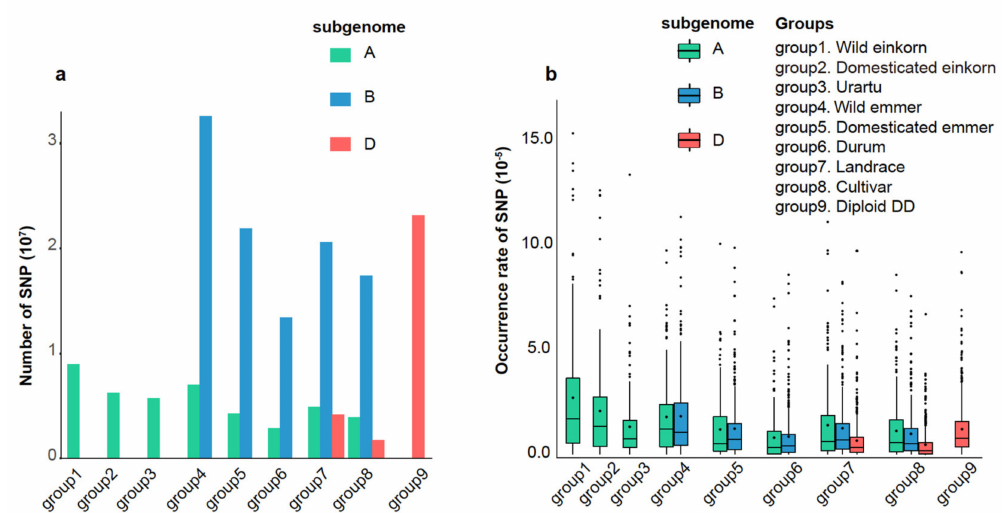
Figure 3. The total number of SNPs in each group and occurrence rate of SNP on NLRs for nine groups in different subgenomes. ( a ) The total number of SNPs in each group. Green bars represent the A subgenome; blue bars represent the B subgenome; red bars represent the D subgenome; ( b ) the occurrence rate of SNP on NLRs for nine groups in different subgenomes. Green boxes represent the A subgenome; blue boxes represent the B subgenome; red boxes represent the D subgenome. The rhombic point in each bar represents the average value. Occurrence rate = number of SNPs on each NLR gene/number of SNPs on the chromosome in which the gene is